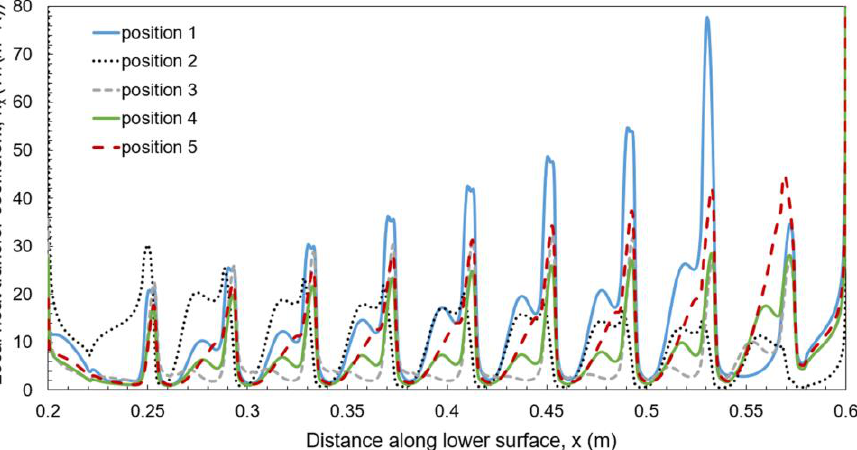
Figure 13. The comparison of local heat transfer coefficients along lower surfaces of the WCCB15 for CVGs position ‘1’ to ‘5’ and Re = 857.